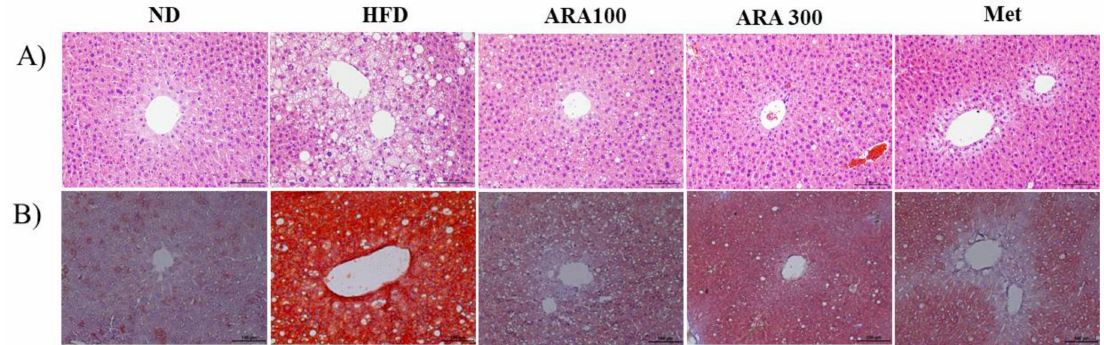
Figure 3. Effects of ARA on lipid accumulations in livers. ( A ) hematoxylin and eosin staining in liver